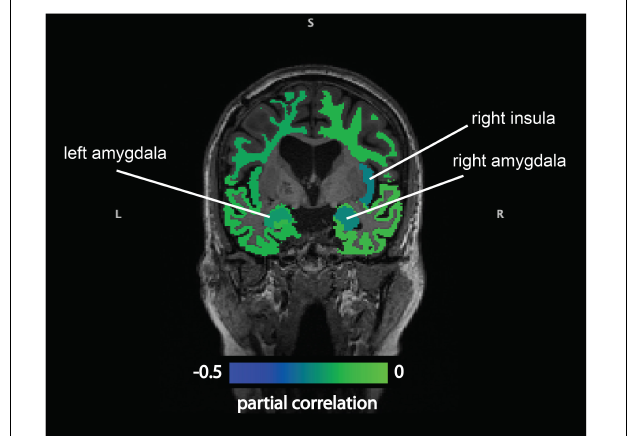
FIGURE 2 | Partial Spearman’s correlations between cerebrospinal fluid cortisol and DHEAS and cerebrospinal biomarkers of Alzheimer’s disease (adjusted for age and sex). CSF, cerebrospinal fluid; DHEAS, dehydroepiandrosterone sulfate; tau, total tau; p-tau, hyperphosphorylated tau; p’, p -values adjusted according to Holm–Bonferroni’s method. * p < 0.05; ** p < 0.001.